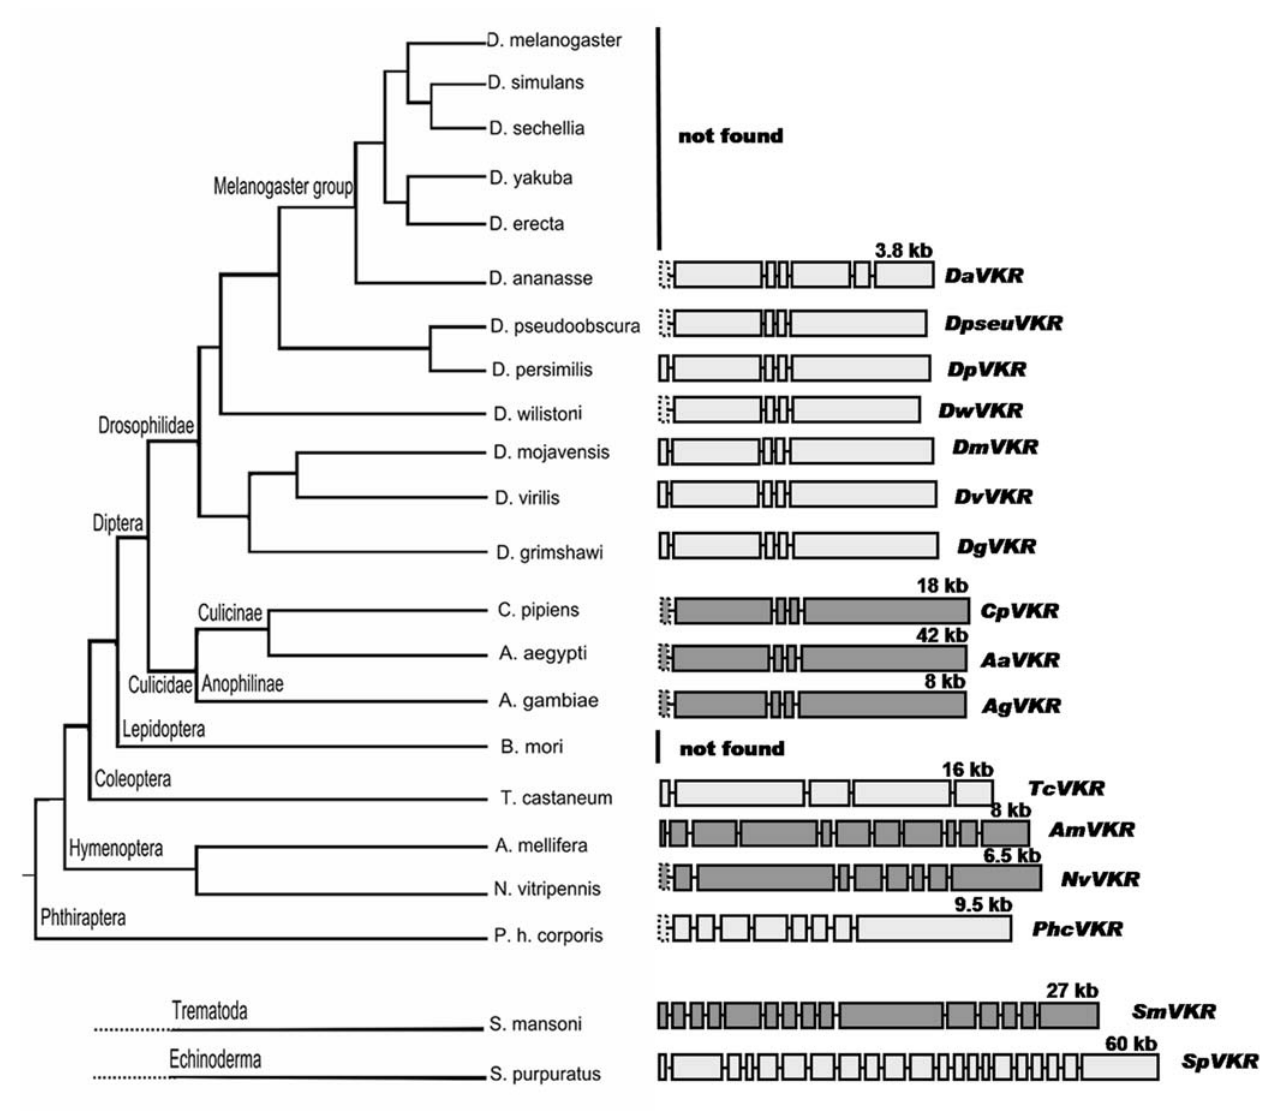
Figure 2. Genomic structure of vkr genes. Genes were ordered following the FlyBase hierarchical tree that showed insect species for which data were available. Predicted exons were represented by rectangles drawn to scale for each vkr gene. Genes of seven Drosophila species ( D. ananasse , D. pseudoobscura , D. persimilis , D. wilistoni , D. mojavensis , D. virilis , and D. grimshawi ), three mosquitoes ( C. pipiens , A. aegypti , A. gambiae ), the coleopteran T. castaneum, two hymenopteran species ( A. mellifera and N. vitripennis ), the phthirapteran P. humanus corporis , the trematode S. mansoni and the echinoderm S. purpuratus are presented. Numbers indicate respective gene lengths in kilobases. Not found indicates that the presence of the vkr gene was not found in the species